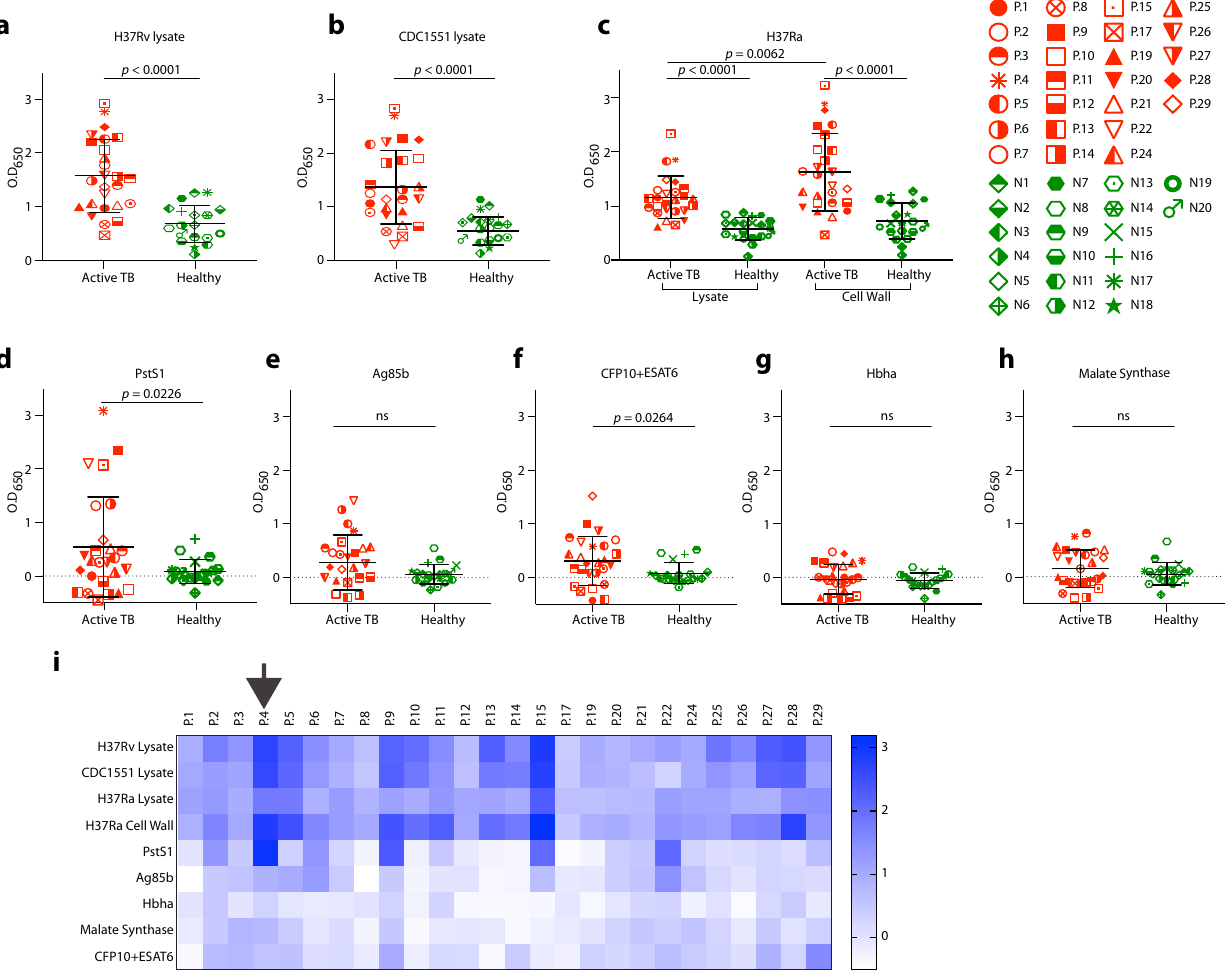
Fig. 1 Serological pro fi le of 26 Israeli actively infected tuberculosis patients. Serum responses by ELISA against a Mtb-H37Rv lysate, b Mtb-CDC1551 lysate, c Mtb-H37Ra lysate and cell-wall fraction, and recombinant proteins d PstS1, e antigen 85b (Ag85b), f CFP10 + ESAT6 complex, g Hbha, and h Malate Synthase. Every symbol represents a single patient, with the legend given on the right side of the fi gure. ATB patients are in red symbols and negative community controls are in green symbols. A heat map summarizing ELISA signals against the different antigens and lysates is shown in ( i ). Donor P.4 is marked with a black arrow. All error bars are represented as mean ± SD. All statistics were derived for n = 26 ATB patients versus n = 20 negative community controls, except for ( a , b ) n = 19 negative community controls. Signi fi cance was determined using a two-tailed unpaired Welch ’ s t test. ns no signi fi cance. Data are representative of at least two independent